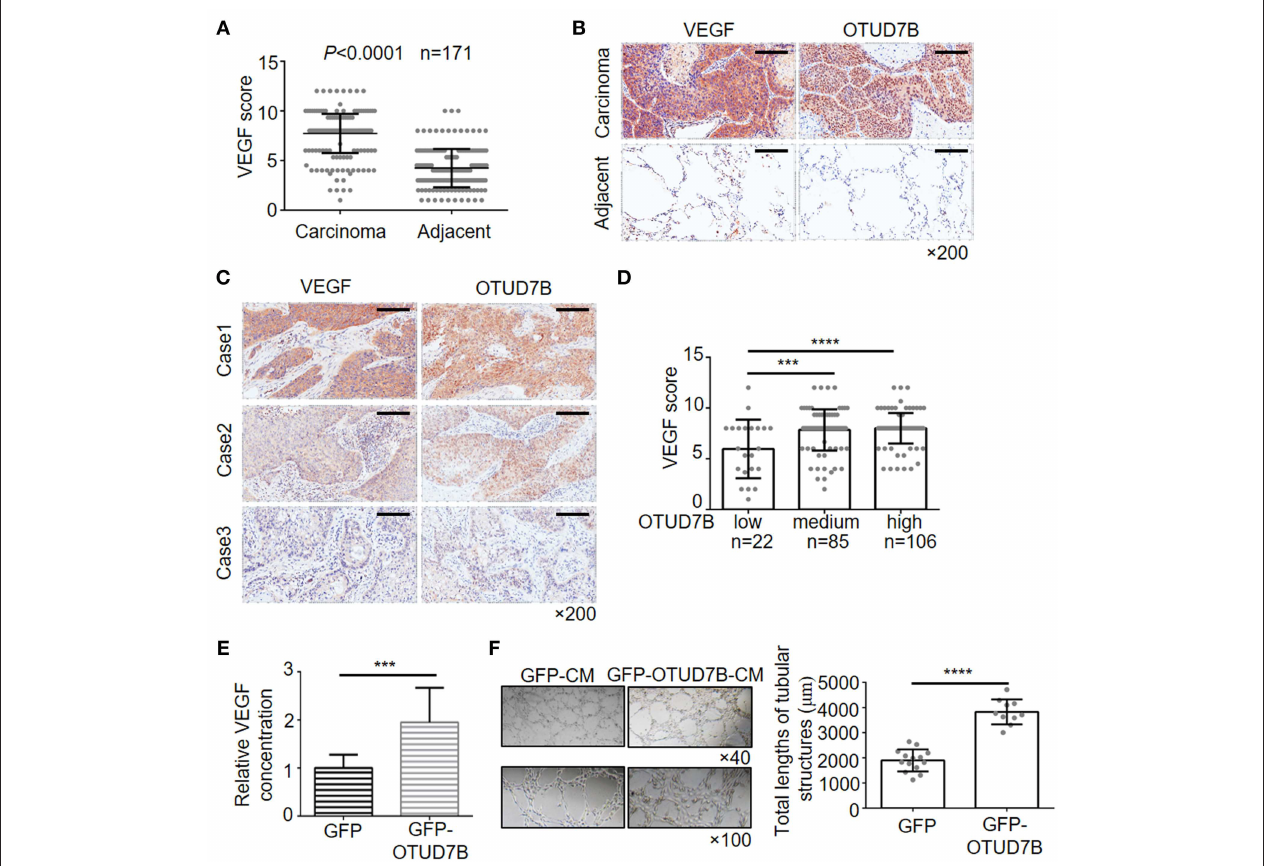
FIGURE 4 | Positive correlation of OTUD7B with VEGF expression and its role in VEGF production and angiogenesis. (A) The expression scores of VEGF ( n = 171) were compared between NSCLC tumors and matched adjacent normal tissue using paired t- test. Data are shown as mean ± s.d. (B) Representative images from IHC staining of VEGF in the same NSCLC tumor. Magnification, × 200; Scale bars, 100 µ m. (C) Representative images from IHC staining of VEGF and OTUD7B expression in two serial sections of the same tumor from three cases. Magnification, × 200; Scale bars, 100 µ m. (D) Scatter dot plots of VEGF expression in NSCLC from 213 subjects. The subjects were divided into three groups based on OTUD7B expression scores in the tumors, representing low, medium and high expression of OTUD7B. Data were analyzed by one-way ANOVA and Tukey’s multiple comparisons test. (E) Media from GFP- or GFP-OTUD7B-overexpressing NCI-H358 cells was removed, washed in RPMI-1640 with 0.5% FBS and incubated for an additional 24h in RPMI-1640 with 0.5% FBS. GFP-conditioned media (GFPCM) and GFP-OTUD7B-conditioned media (GFP-OTUD7B-CM) were collected, and VEGF expression were analyzed by ELISA. Absorbance was measured at 450nm. (F) EA.hy926 endothelial cells were pretreated with GFP-CM and GFP-OTUD7B-CM for 24h. Subsequently, pretreated EA.hy926 cells were seeded on Matrigel for 8h to observe tube formation. Representative photographs are shown (left). Tube lengths were quantitated using IMAGE-PRO PLUS software ( n = 5 per group). Data are shown as mean ± s.d. *** P < 0.001, **** P <